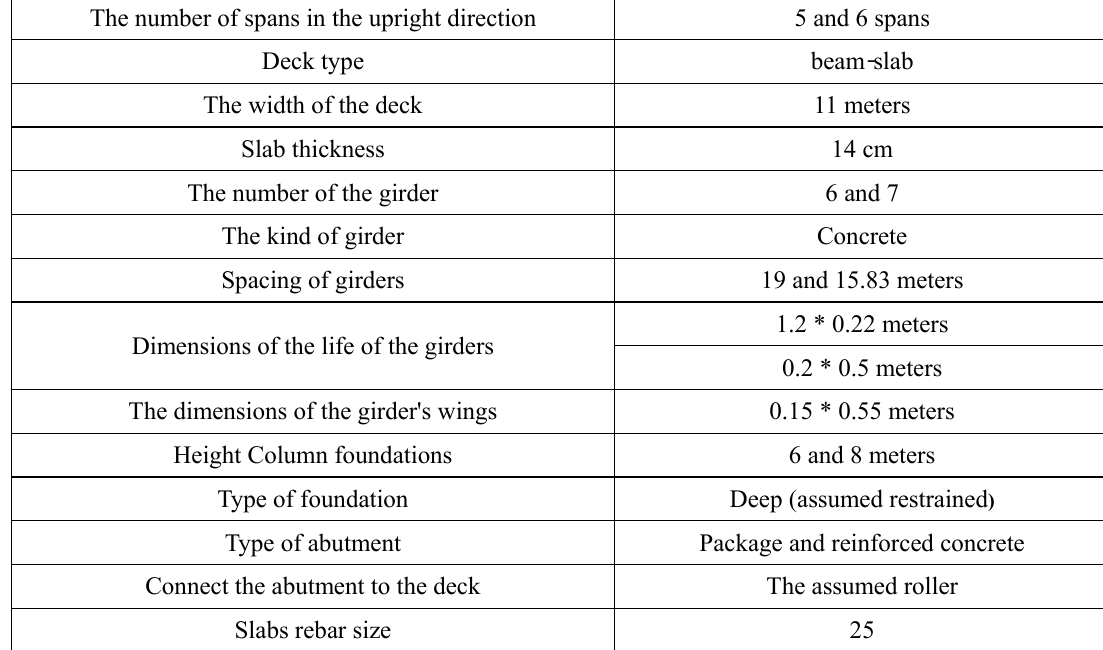
Fig. 2. Cross section of bridge decks. General specifications of the